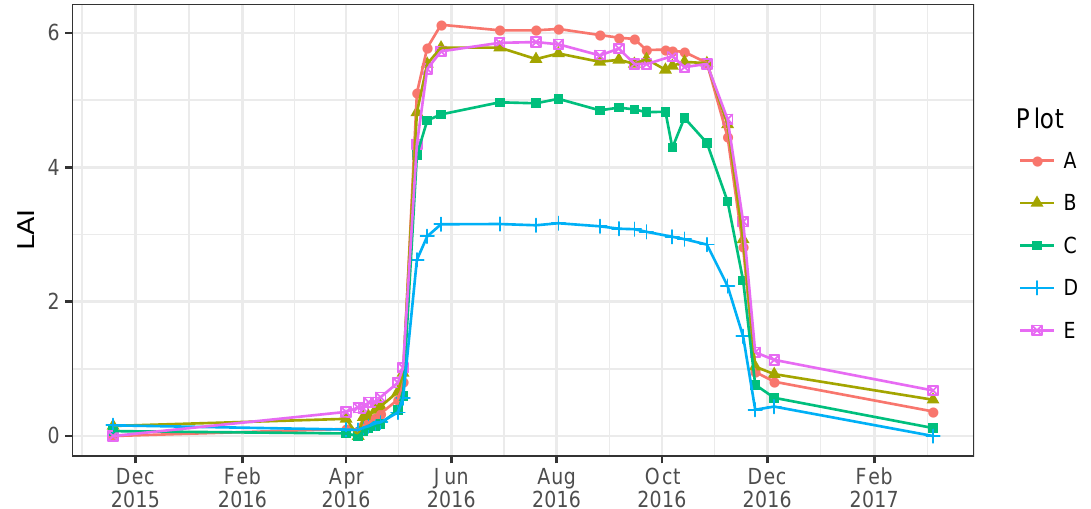
Figure 6. Speulderbos LAI time series for 2016 derived from TLS, points are observations. Lines are linear interpolations. Interpolations for outside of the measurement campaign were performed with the values from the previous and next year, which are added to the graph for